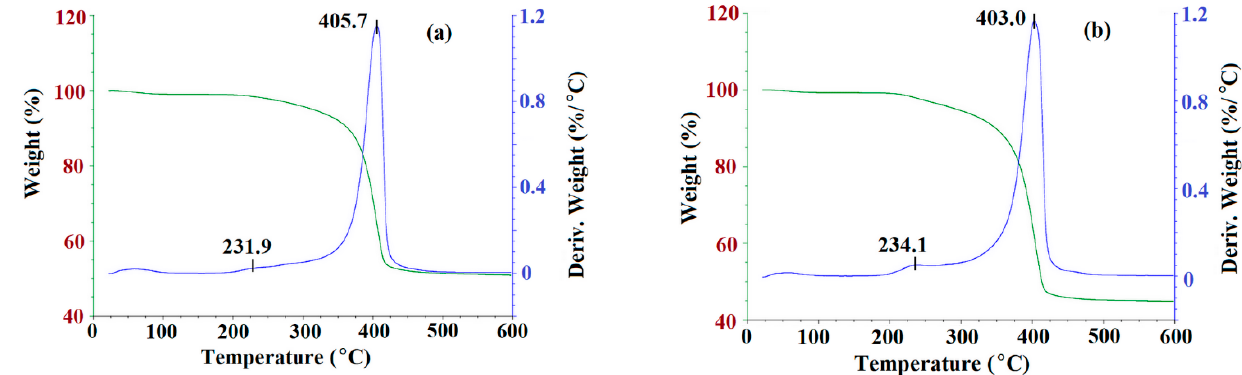
Figure 4. TGA curves of m-MIP ( a ) and m-NIP ( b ): Green line presents the loss of weight as the function of temperature; blue line is a derivative of weight loss as the function of temperature.